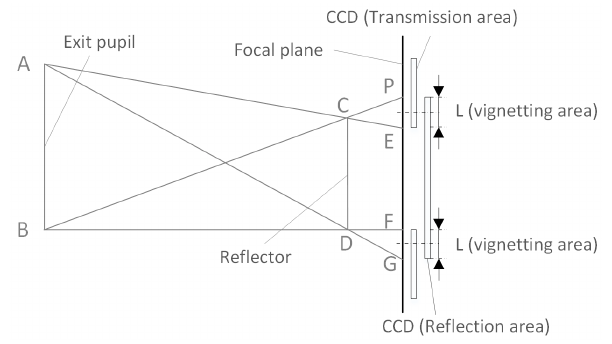
Figure 4. Vignetting in the focal plane-based optical butting [27].